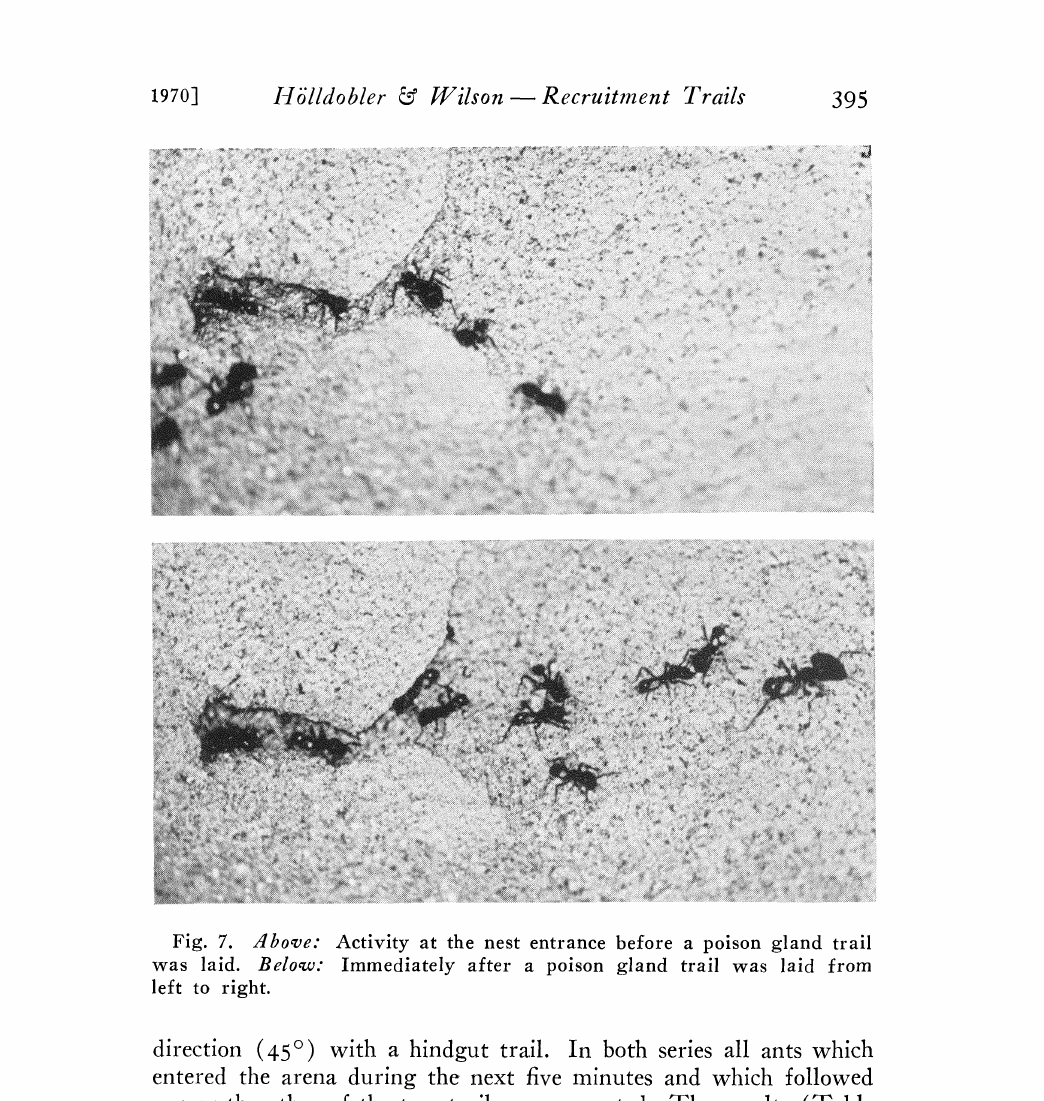
Fig. 7. Abo,ve: Activity at the nest entrance before a poison gland trail was laid. Belo,w: Immediately after a poison gland trail was laid from left to